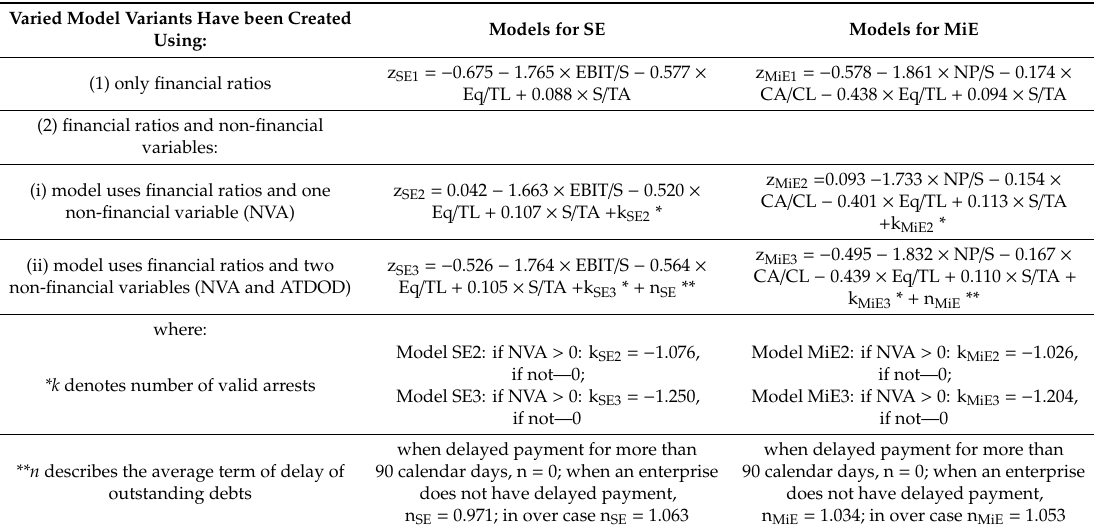
Table A5. The calculation of coe ffi cient z for the logistic regression enterprise trade credit risk assessment (ETCRA) models for small (SE) and micro-enterprises